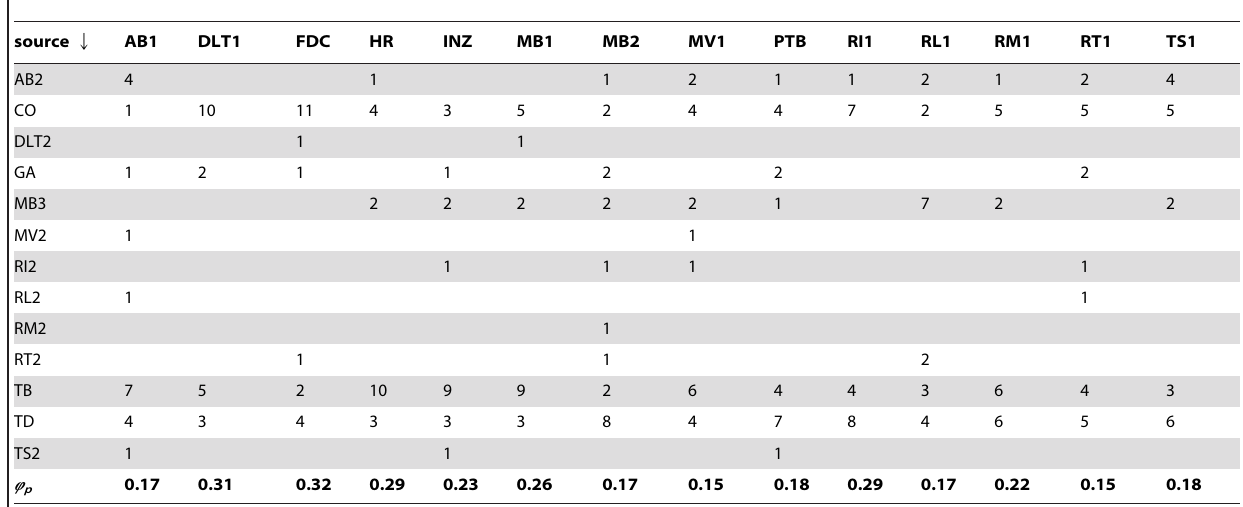
Table 4. Assignment of individuals of recent populations (columns) to old populations (rows).